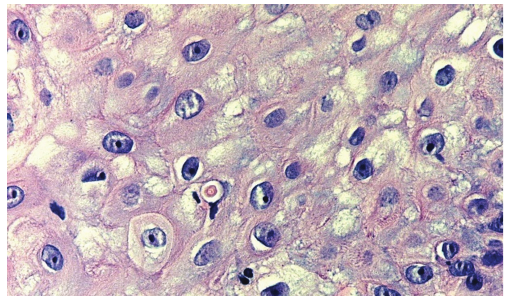
Figure 3: One red intranuclear inclusion in the keratinocyte of the